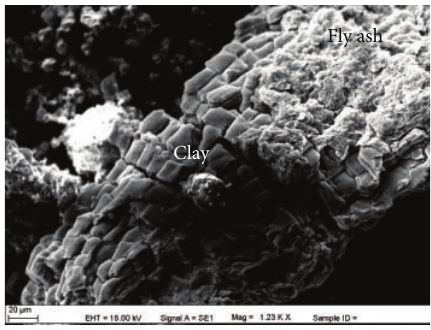
Figure 16: The SEM view of coated clay with ash pellets.